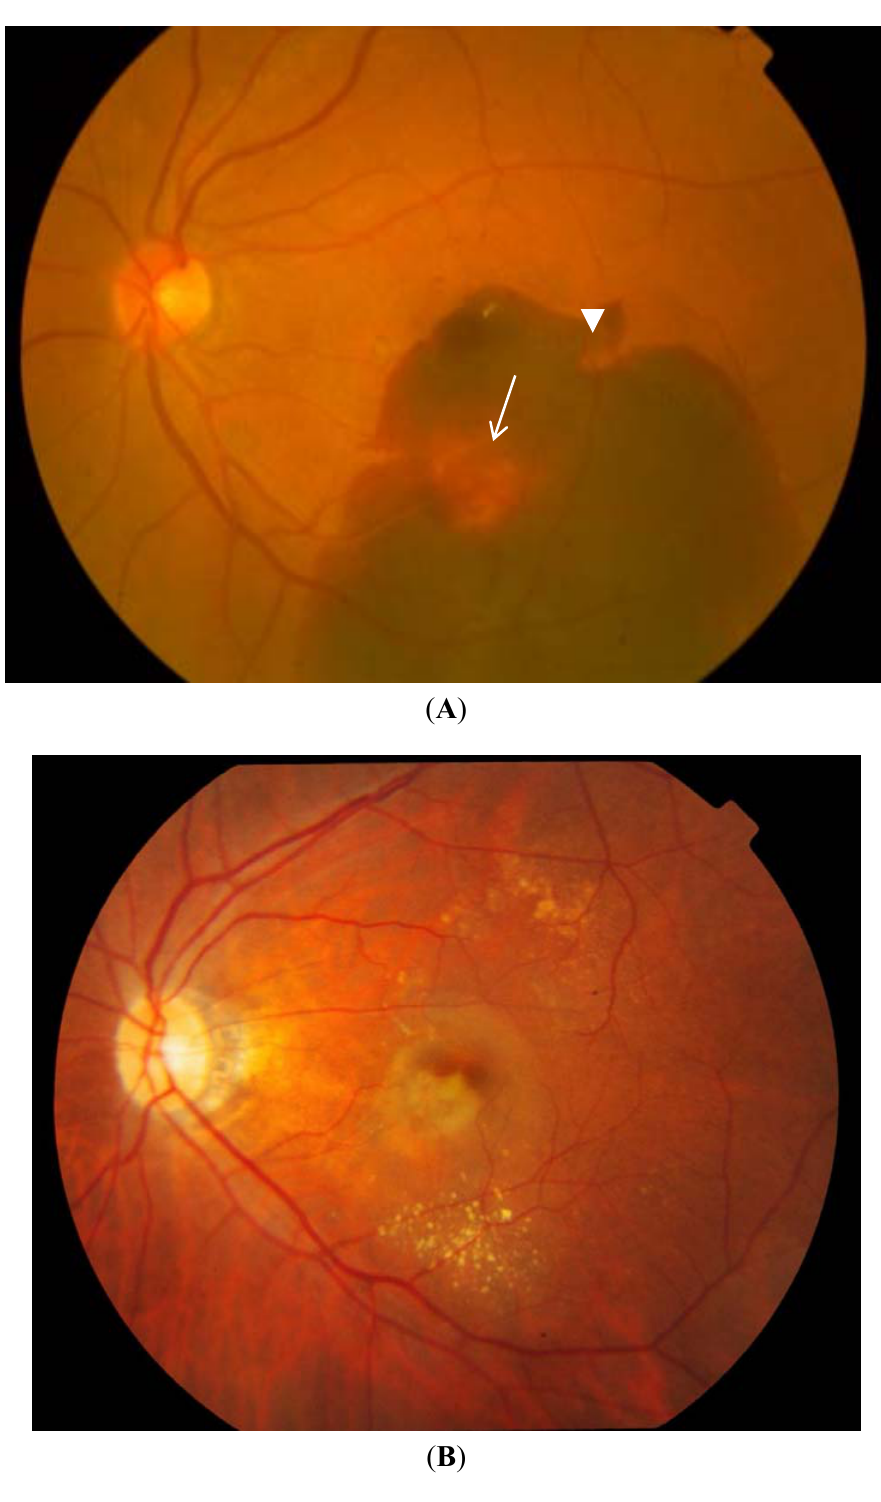
Figure 1. Fundus photographs showing the two clinical patterns of polypoidal choroidal vasculopathy: Hemorrhagic ( A ) and exudative ( B ). An orange red nodule suggestive of a polyp (white arrow) is seen in an extrafoveal position, while a notch in the hemorrhagic pigment epithelial detachment (white arrowhead) suggests the presence of another